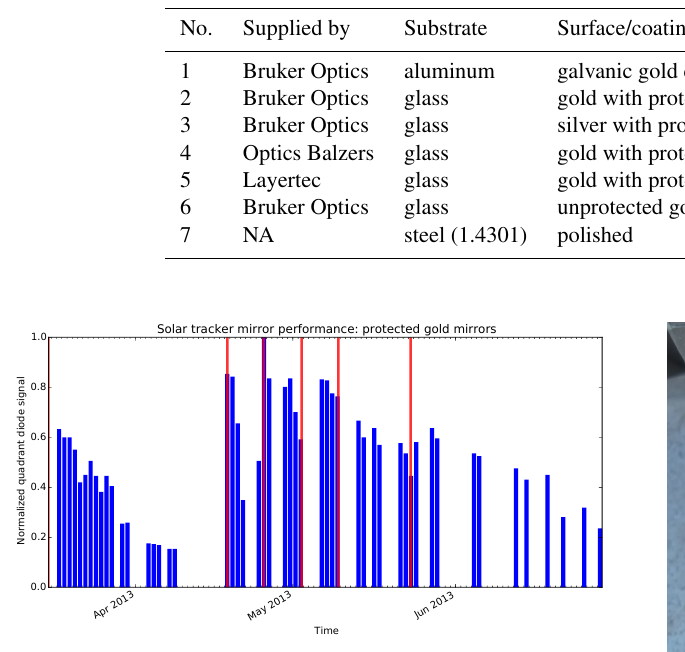
Figure 4. Reflectance loss of the protected gold-coated mirrors (Layertec), like Fig. 3. Red vertical lines indicate when the mirrors were cleaned.